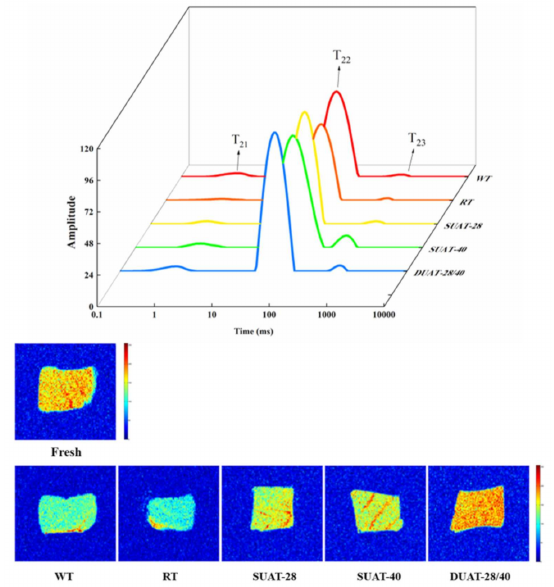
Figure 5. Differences in water distribution and magnetic resonance imaging of large yellow croaker under different thawing methods and in fresh sample. (WT: water thawing; RT: refrigerated thaw- ing; SUAT-28: single-frequency ultrasound-assisted thawing at 28 kHz; SUAT-40: single-frequency ultrasound-assisted thawing at 40 kHz; DUAT-28/40: dual-frequency ultrasound-assisted thawing at 28 kHz and 40